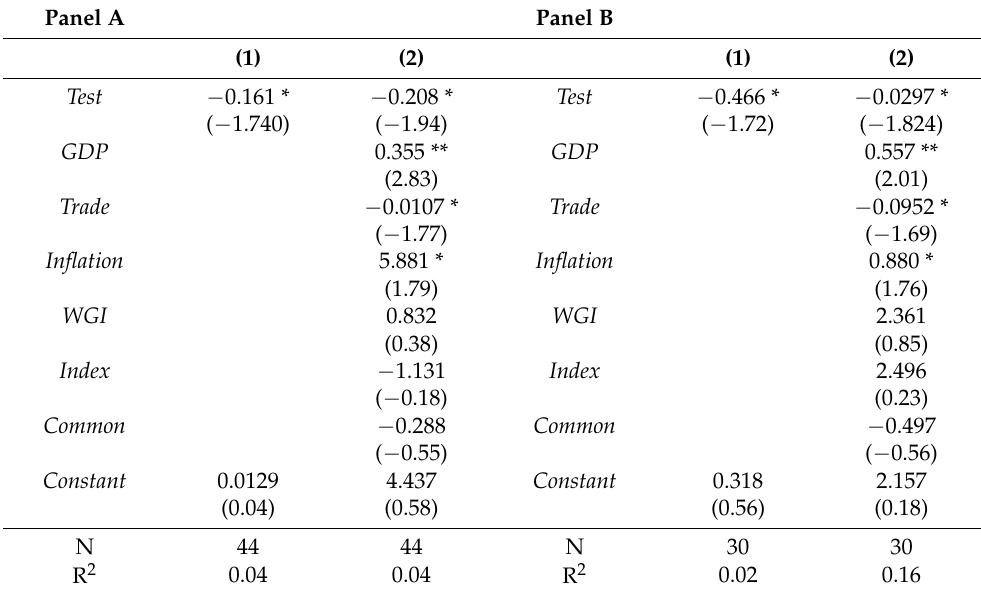
Robust t -statistics are shown in parentheses. **, * indicate significance at 1%, 5%, and 10% levels,